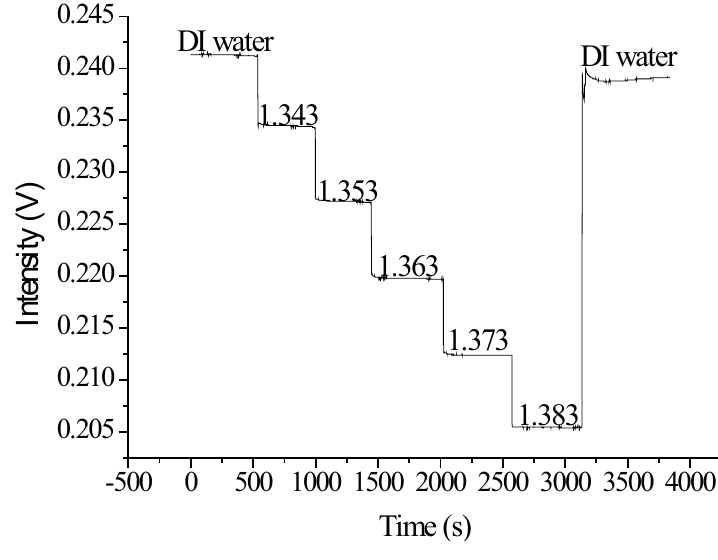
Figure 23. Plot of the PPR fiber sensors’ temporal response to injections of increasing sucrose solution concentrations and refractive indices .